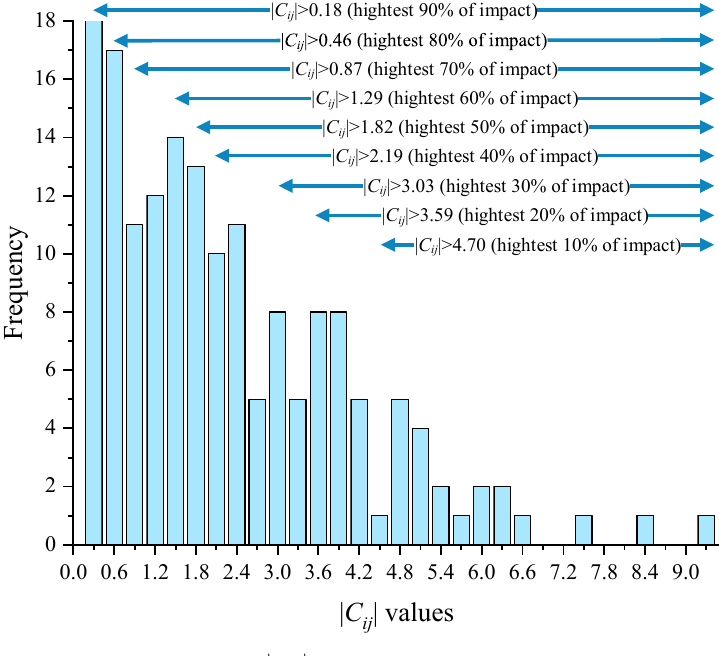
Figure 3. Histogram of the (cid:3627)𝐶 (cid:3036)(cid:3037) (cid:3627) distribution.